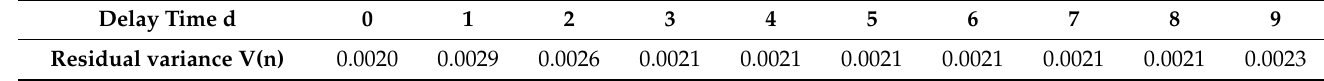
Table 4. Identification errors of V(n) for depth loop with different delay time parameter d.